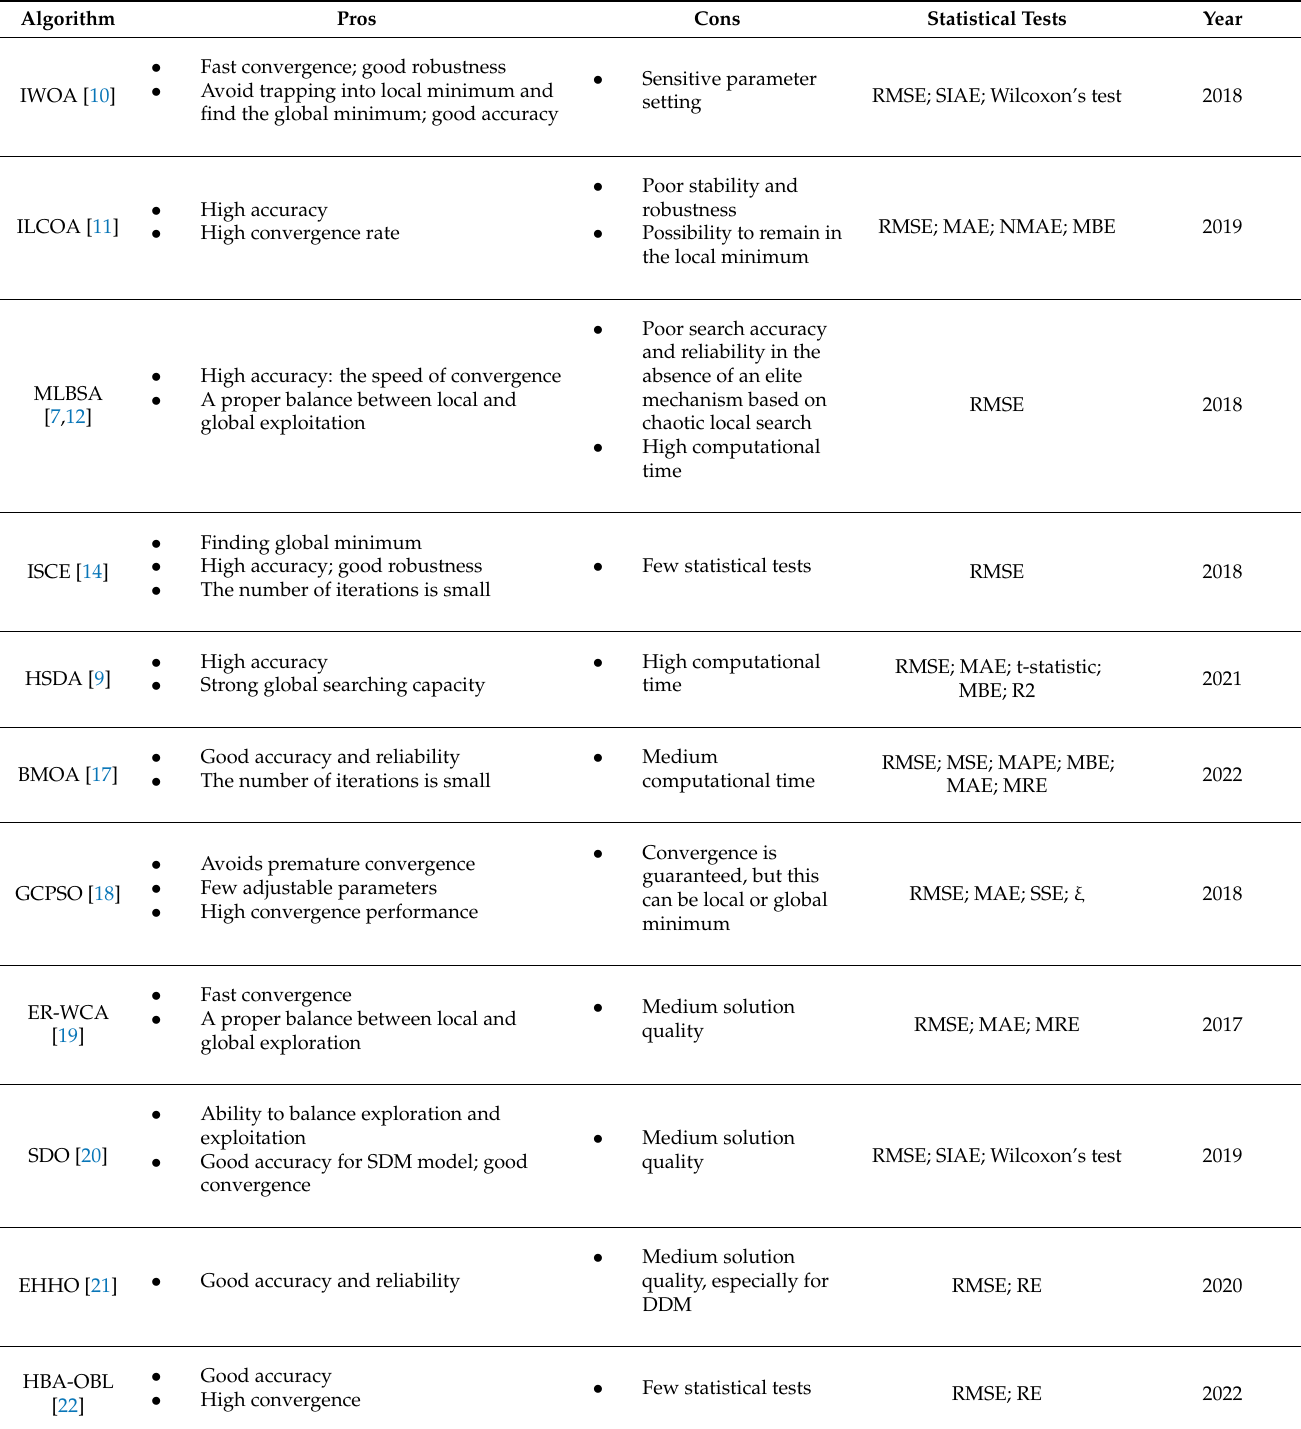
Table 1. Literature review of recent optimization